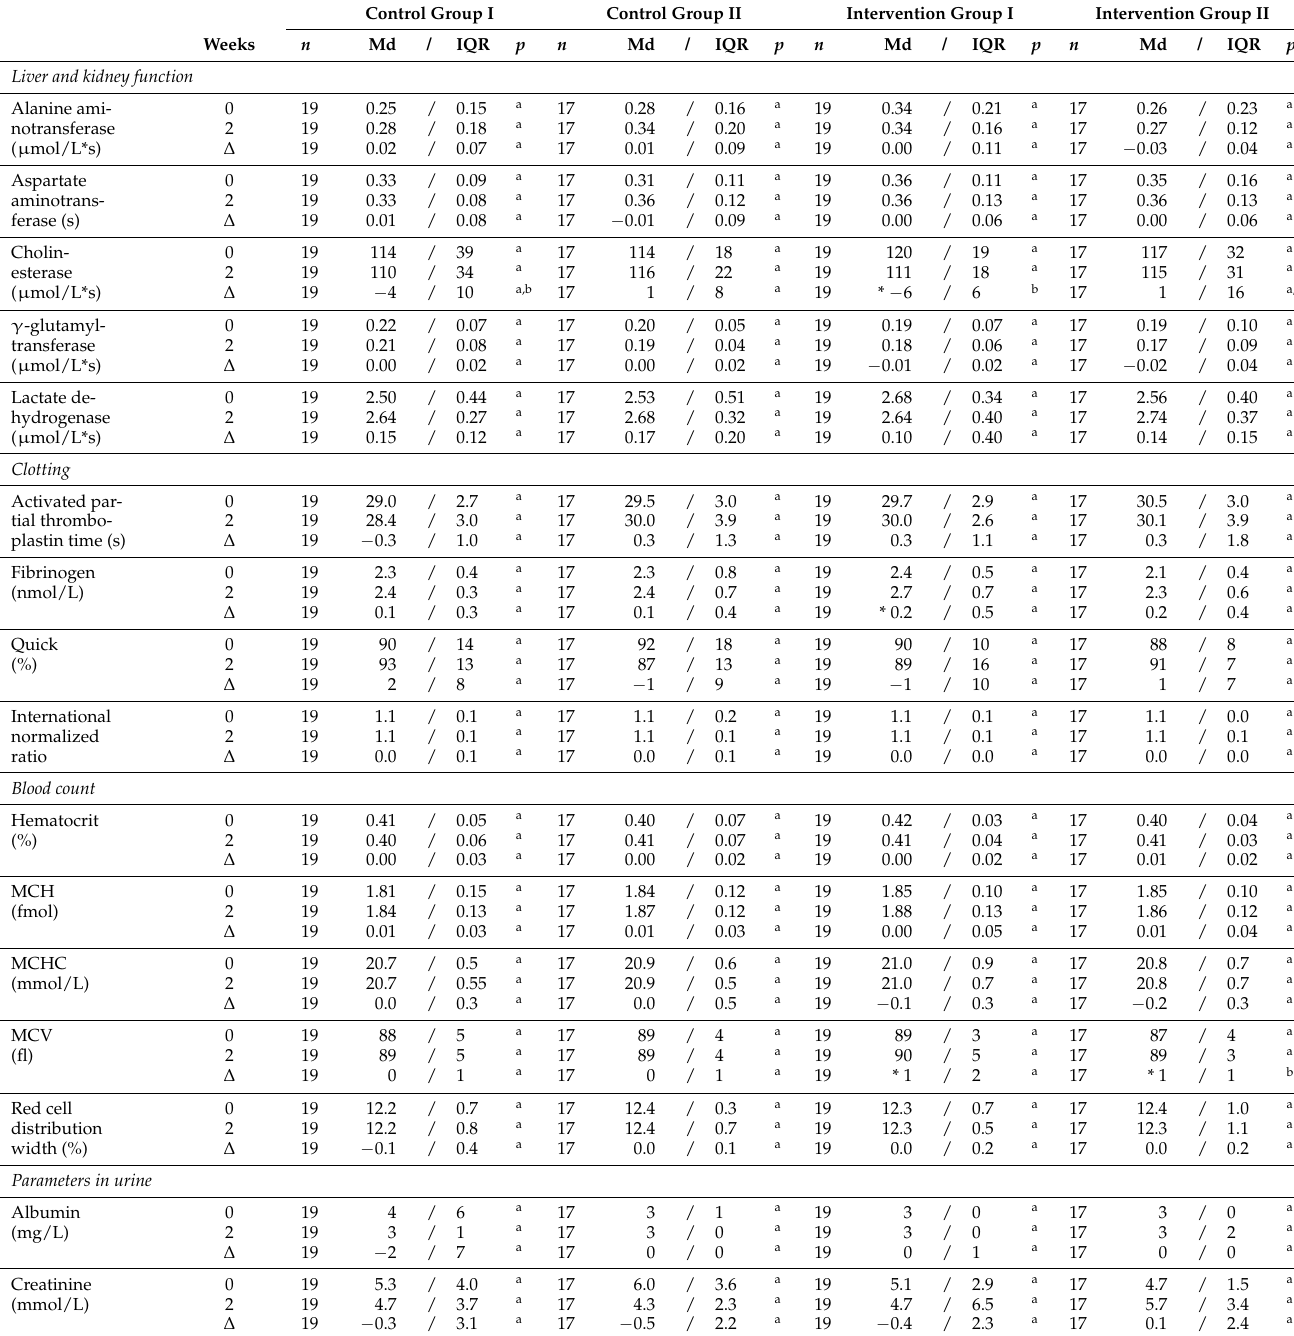
Table 5. Safety parameters of the NovAL study participants ( n =